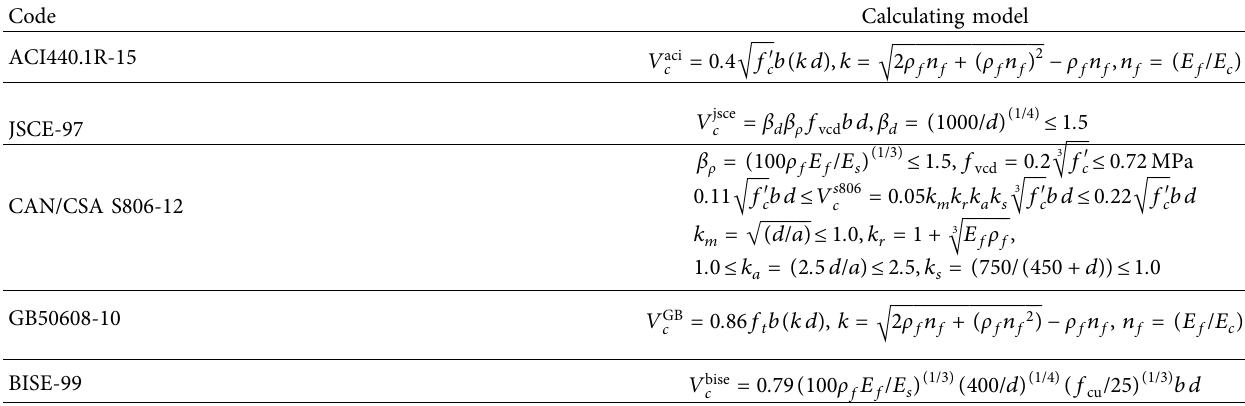
Table 1: Shear strength calculating models in